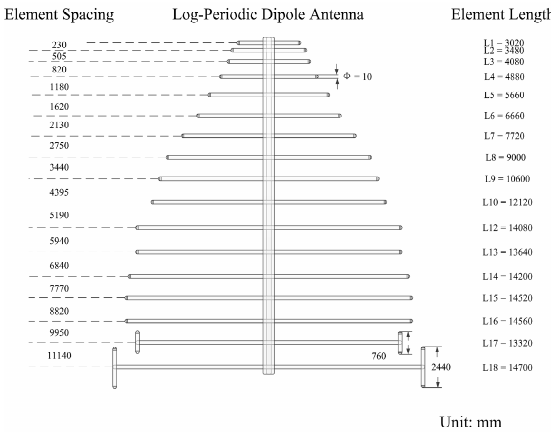
Figure 3. Sketch of the LPDA of the WIOBSS-AA.